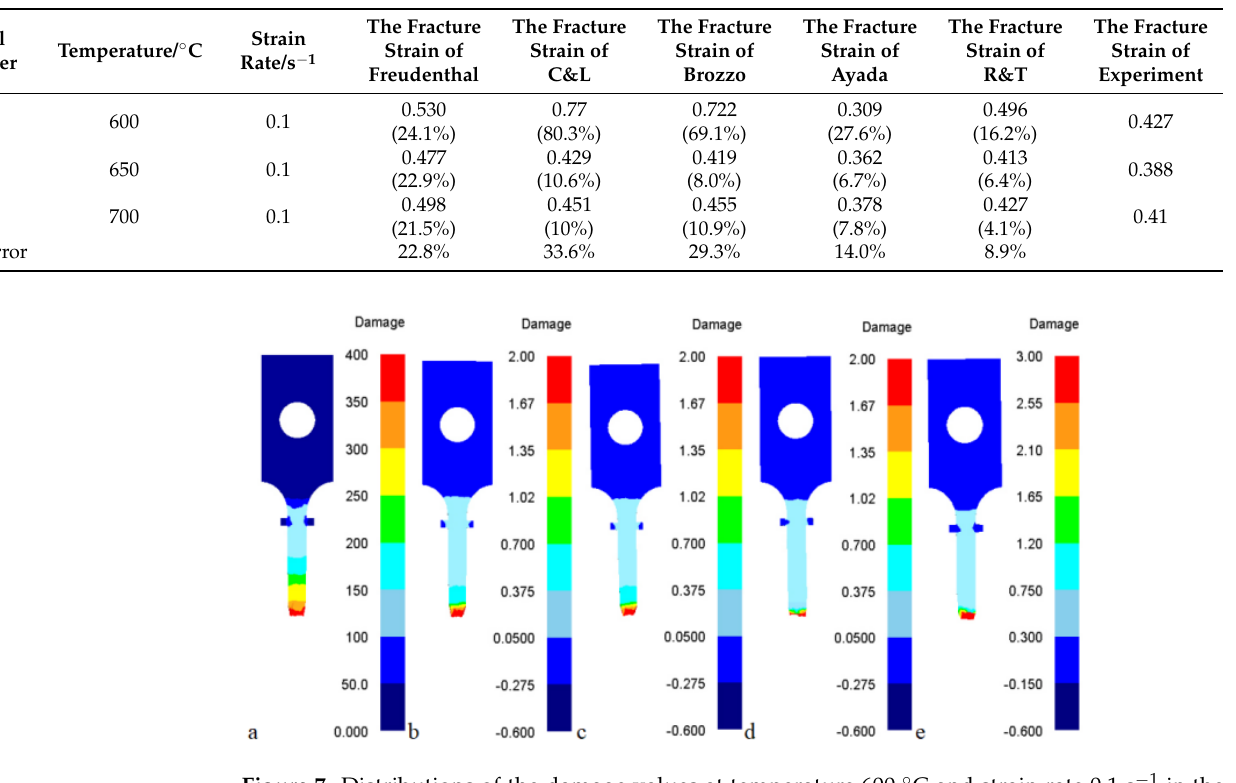
Table 9. The fracture strain obtained by simulation and experiment.